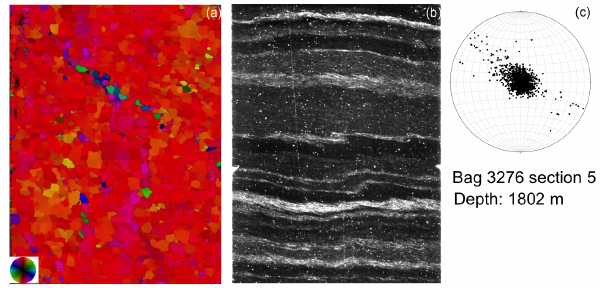
Figure 3. Comparison of fabric data and visual stratigraphy in de- tail, bag 3276, approximate depth 1803m. (a) Fabric data in a ver- tical section, (b) line scan image in a vertical section, (c) stereo plot of c axes orientations (horizontal plane).